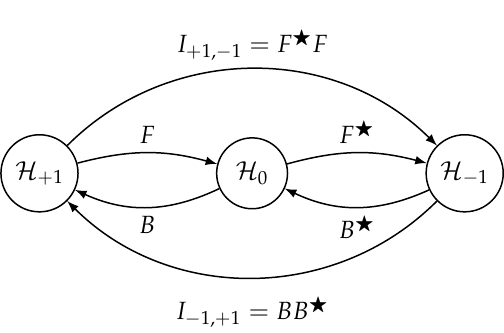
Figure 1. The isometric operators introduced in Theorem